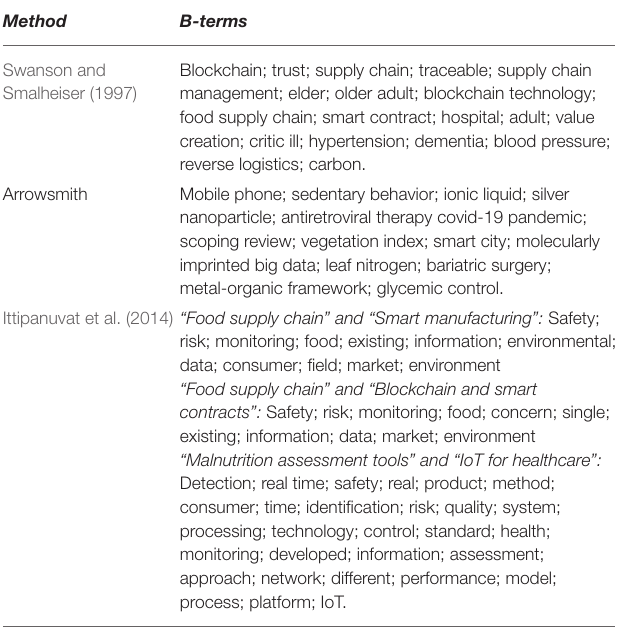
TABLE 7 | B-terms between food security and IoT by using other LBD methods.